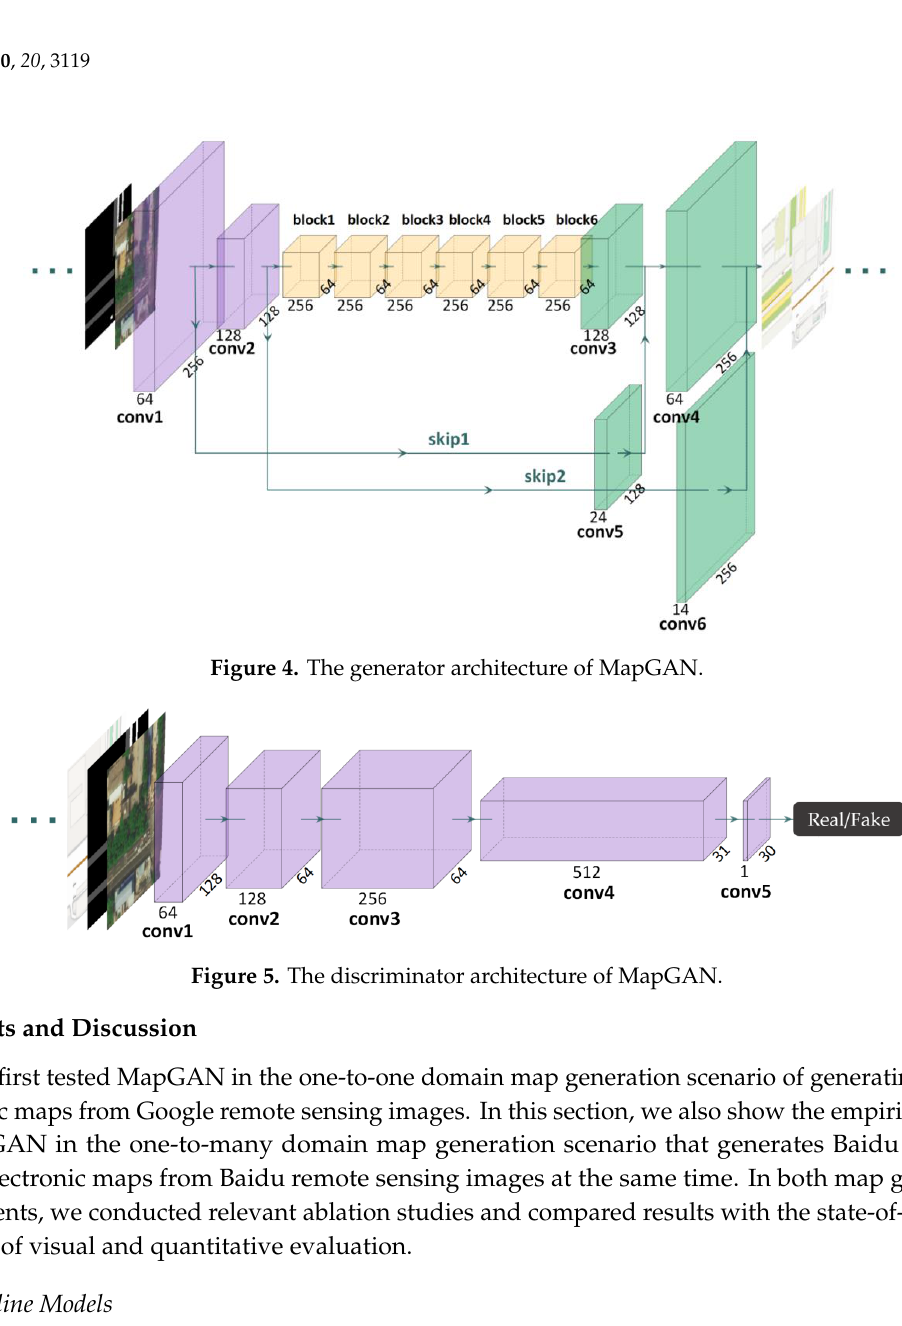
Figure 5. The discriminator architecture of MapGAN.